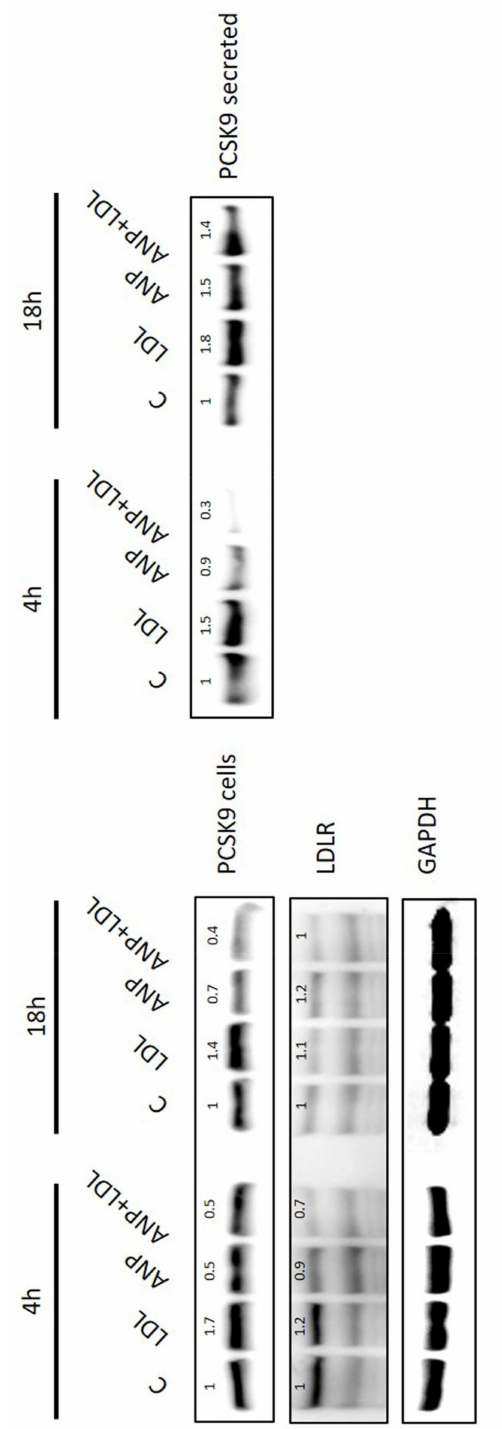
Figure 5. PCSK9, LDLR, and GAPDH levels after treatment with LDL and ANP for 4 and 18